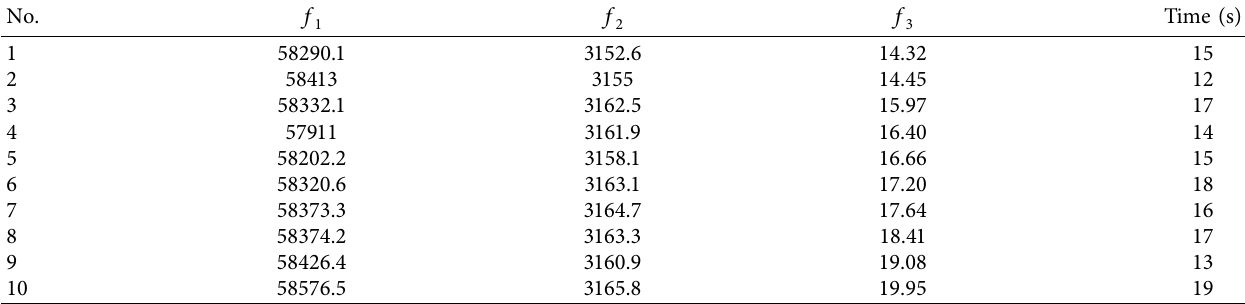
Table 7: Pareto points obtained from solving the model.